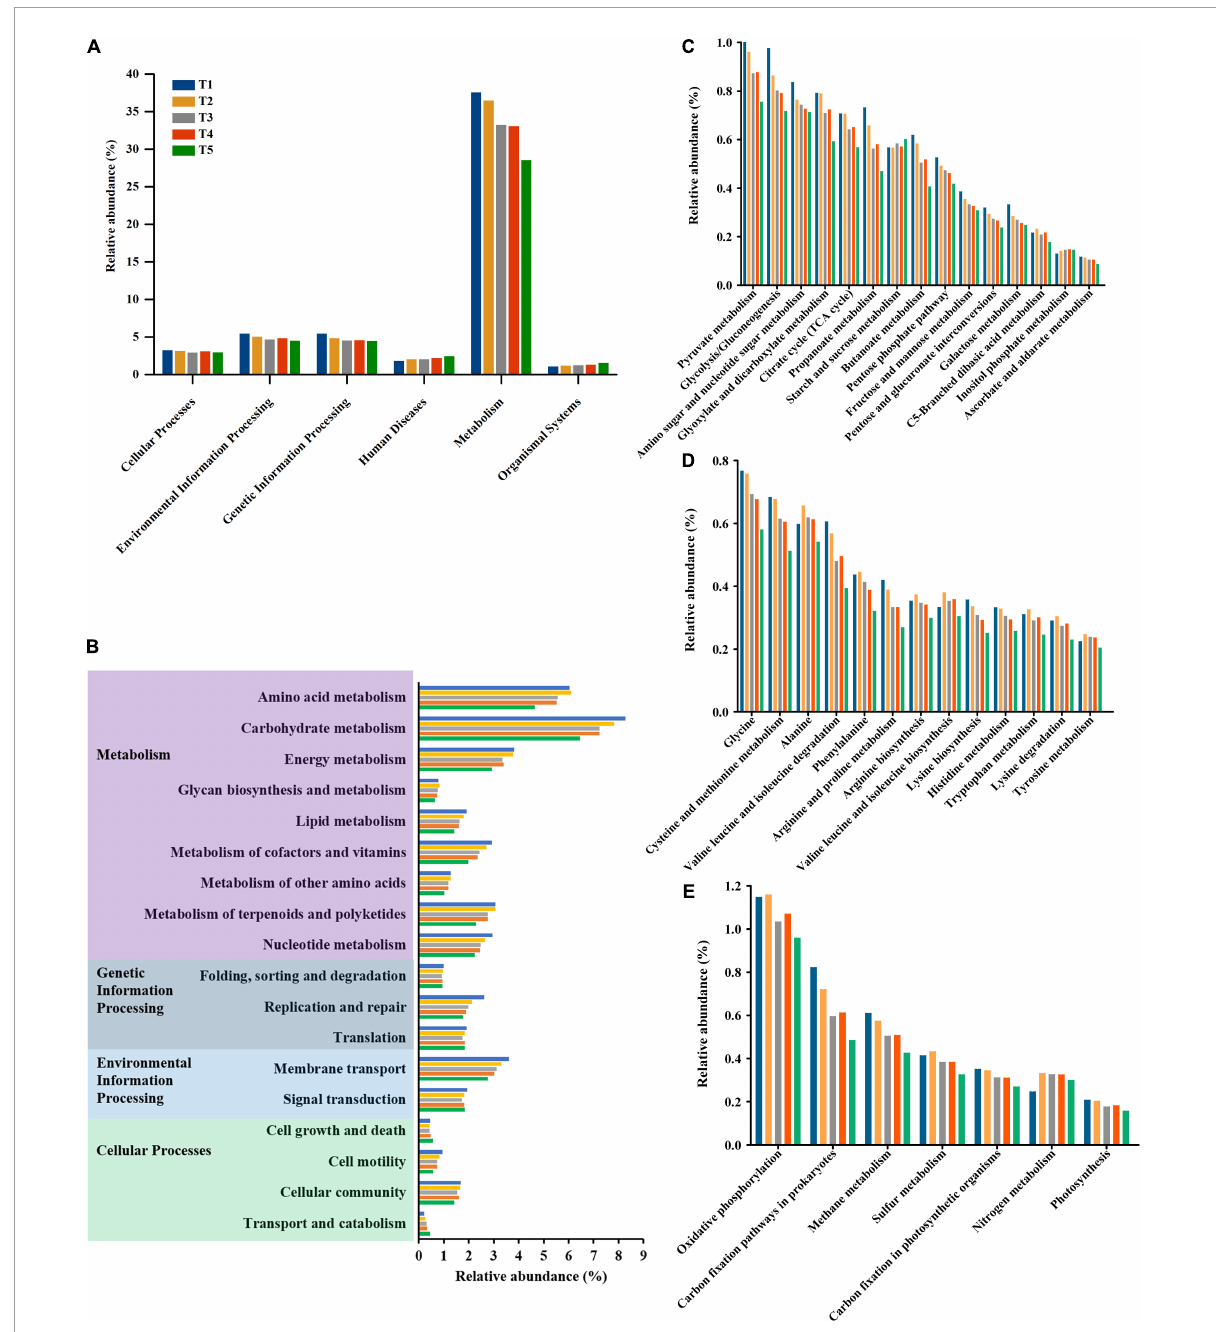
FIGURE5 Variation of microbial functional profiles during the different growth stages of oyster mushroom. (A,B) Show the level 1 and level 2 KEGG ortholog function annotation, respectively; (C) carbohydrate metabolism; (D) amino acid metabolism; (E) energy metabolism. T1, T2, T3, T4, and T5 indicate the day on which composting was completed (day 0: before spawning), mycelial colonization (day 3), mid-incubation (day 10), end-incubation (day 20: before primordia formation), and first oyster mushroom fructification (day 30: fruiting body development), respectively.